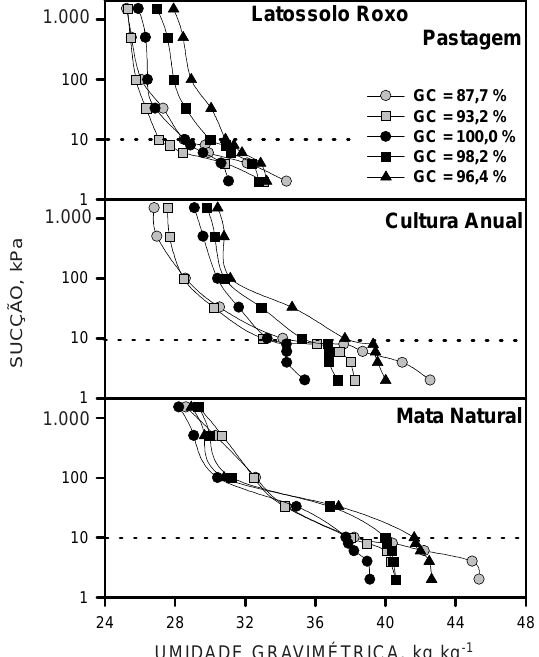
Figura 2. Curvas características de água do solo para diferentes graus de compactação (GC) de um Latossolo Roxo sob cultura anual, mata natural e pastagem.